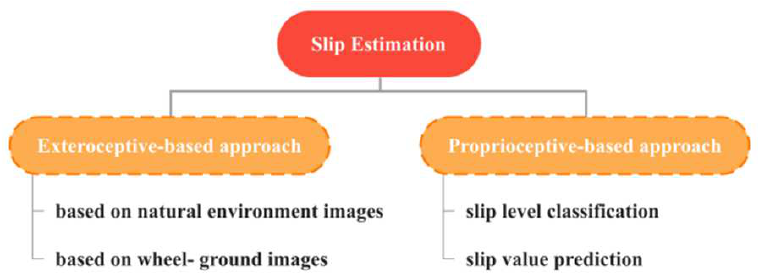
Figure 1. Most common slip estimation approaches for rovers.